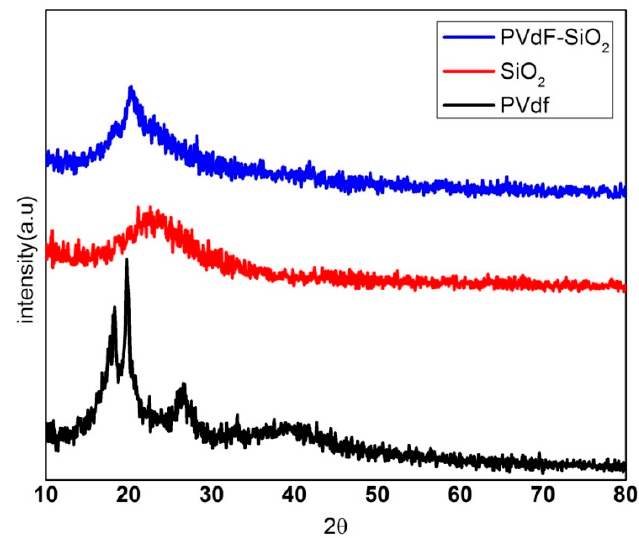
Figure 1. Diffraction pattern of pure PVdF, SiO 2 , and composite of PVdF-SiO 2 , respectively. FT-IR analysis was performed in the range of 400 to 4000 cm − 1 to confirm the existence of the functional groups present in the PVdF-SiO 2 porous membrane shown in the Figure 2.